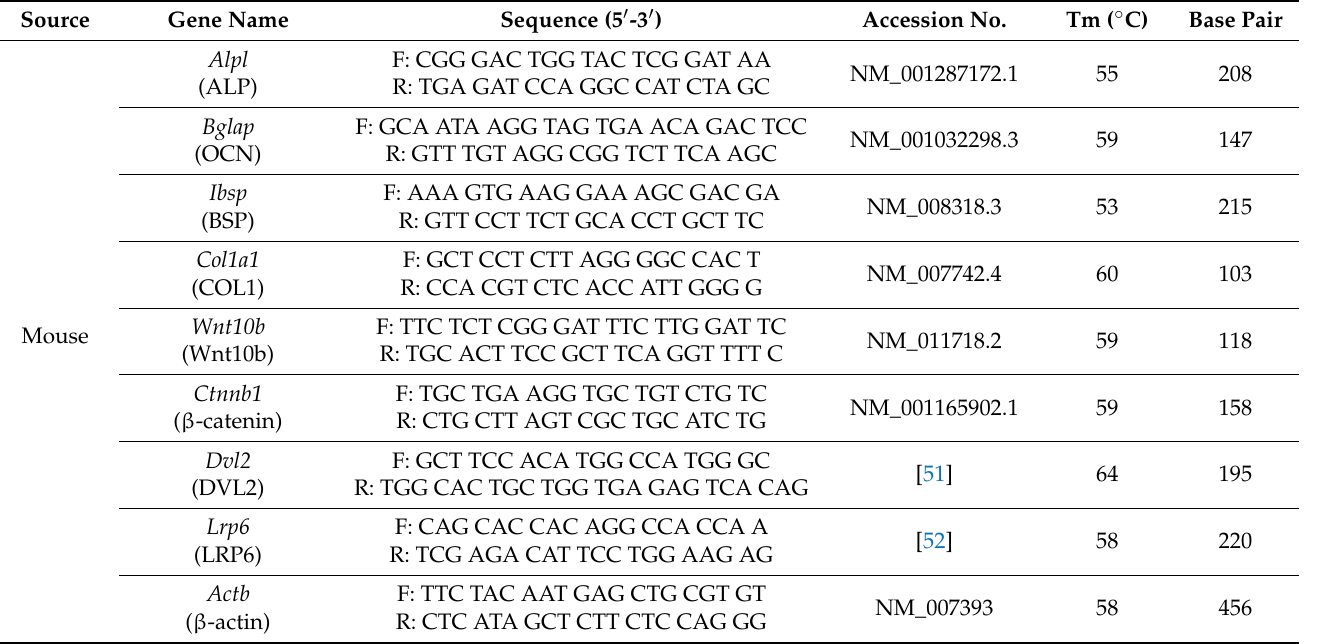
Table 1. Mouse primer sequences used for